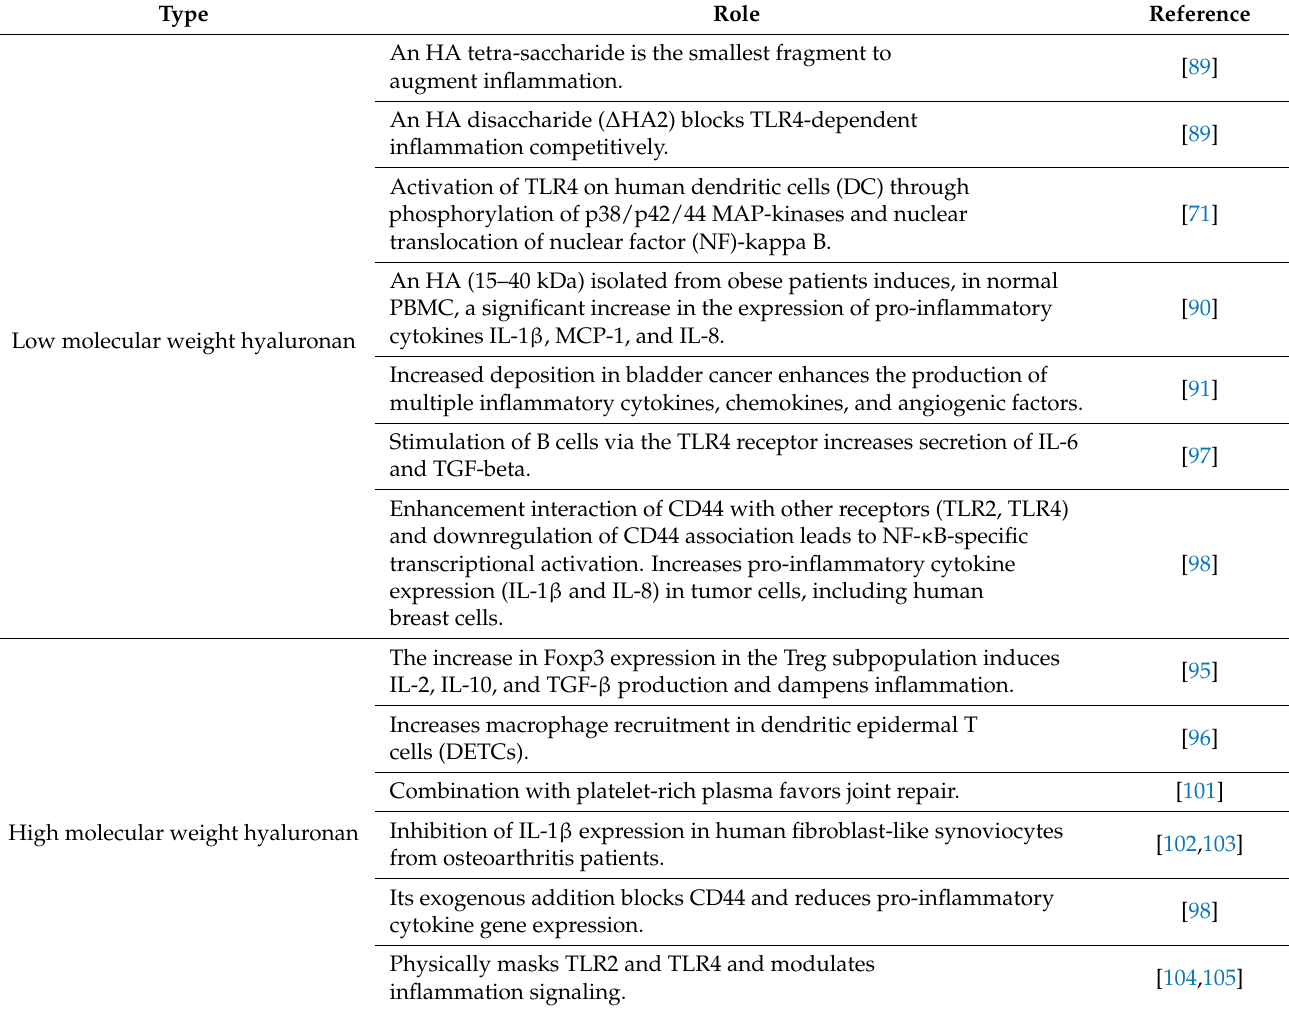
Table 1. Different roles of LMWHA and HMWHA in inflammation events.